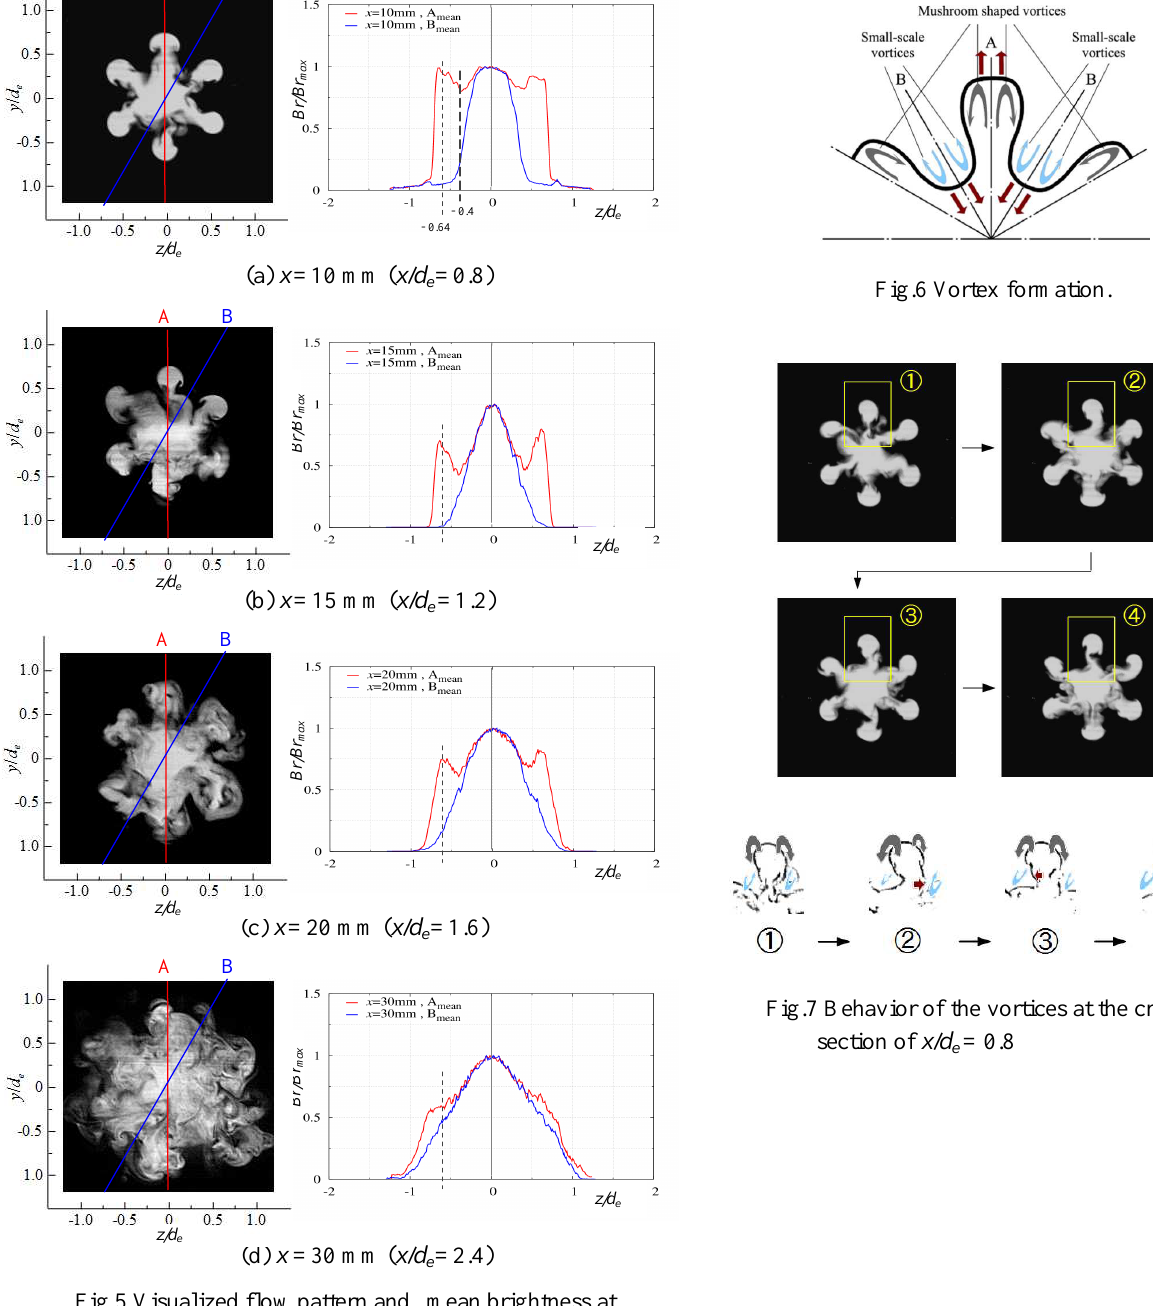
(d) x = 30 mm ( x / d Fig.5 Visualized flow pattern and mean brightness at the cross sections of 6-p jet, Re = 3,000 ( d = d